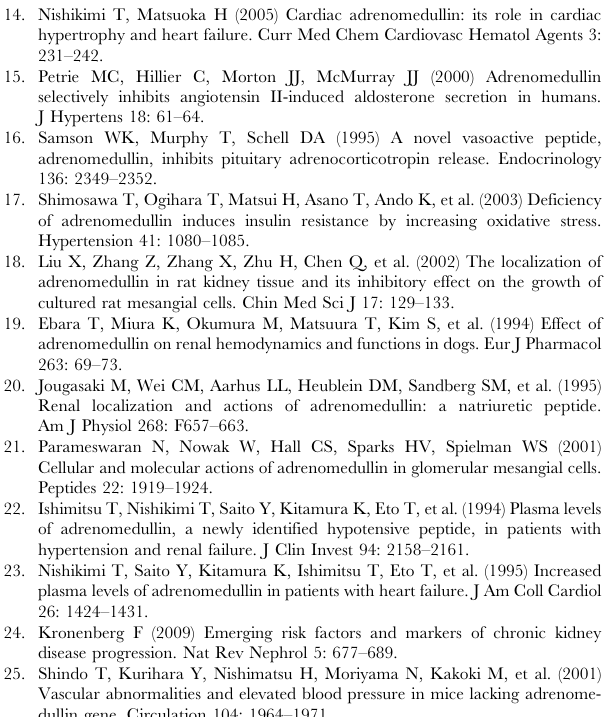
Figure S1 Comparison of gene expression and ERK/ pERK between wild-type and RAMP2 + / 2 mice. (A) Quantitative real-time PCR analysis of VE-cadherin, p53, and TGF- b gene expression in kidney. Data from the wild-type control group were assigned a value of 1. n= 5 in each group. Bars are means 6 SEM. (B) Immunohistostaining of ERK and pERK in the section of kidney. Bars = 100 m m. No change was detected between wild-type and RAMP2 + / 2 mice. Figure S2 Effect of STZ administration in other organs expressing GLUT2. H&E staining of intestine, pancreas, and liver sections sampled from wild-type or RAMP2 + / 2 with or without STZ administration. STZ administration caused cell death in these organs, however, the difference was not apparent between wild-type and RAMP2 + / 2 . Bars = 50 m m.